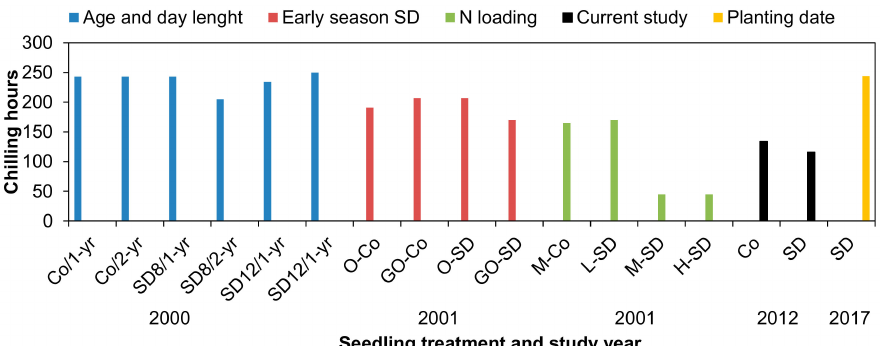
Figure 9. Accumulated chilling hours (sum of hours when temperature was between − 5 ◦ C and + 5 ◦ C) on the date at which frost hardiness of needles of Norway spruce seedlings reached − 25 ◦ C (DT 50 , the temperature causing damage to 50% of the needles). The data from different experiments (indicated by differentbarcolors)werecombinedtodemonstratetheimpactsofvariousnurserytreatmentsandseedling age on the relationship between accumulation of chilling hours and needle FH. All experiments